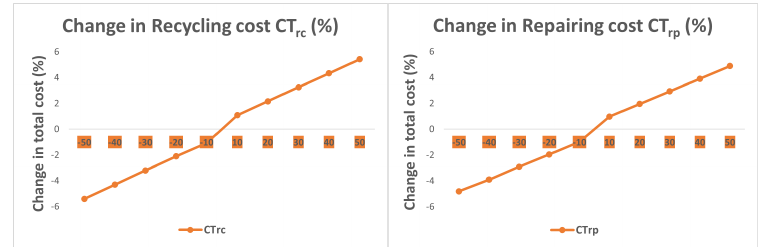
Figure 5. Sensitivity analysis of repairing and recycling